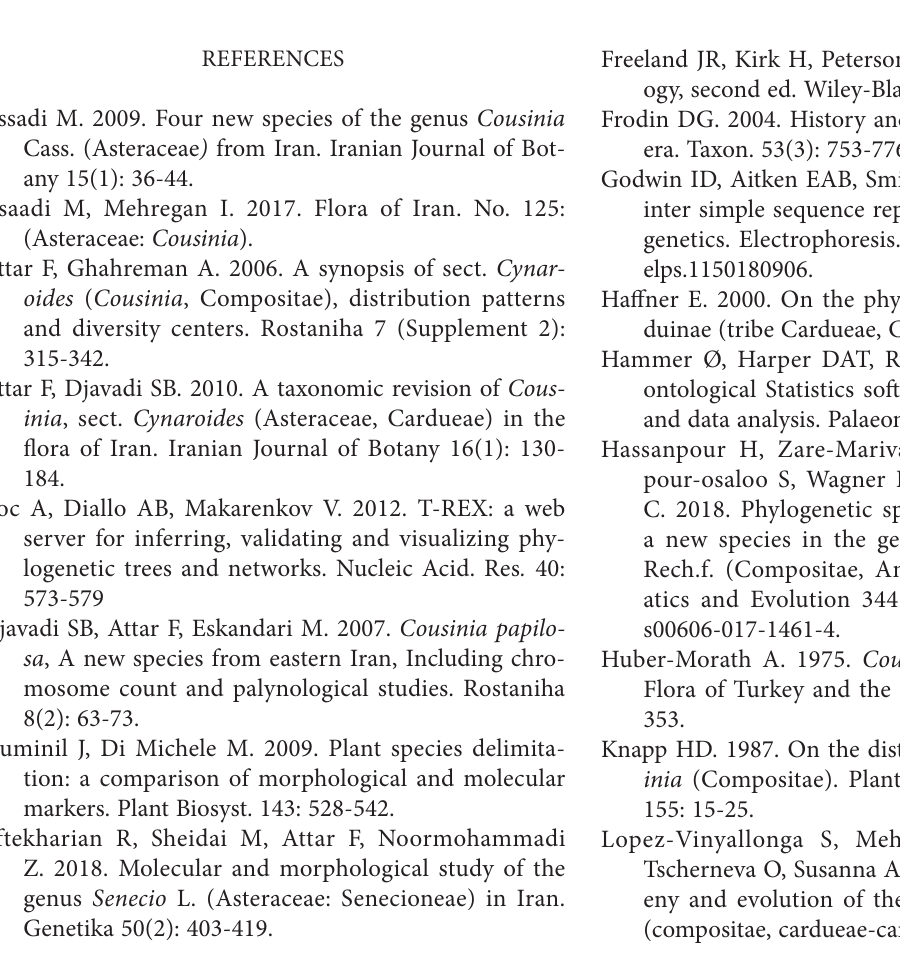
Fig. 3. Consensus tree based on morphological and ISSR dendrograms in studied Cousinia